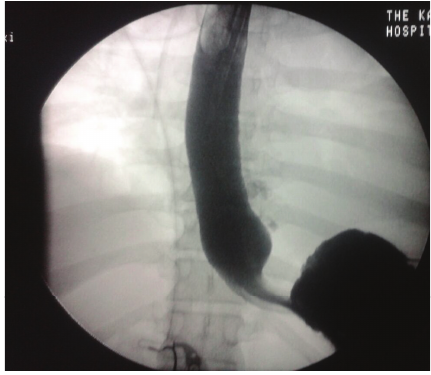
Figure 2: Follow-up gastrografin swallow showing reduced leakage.